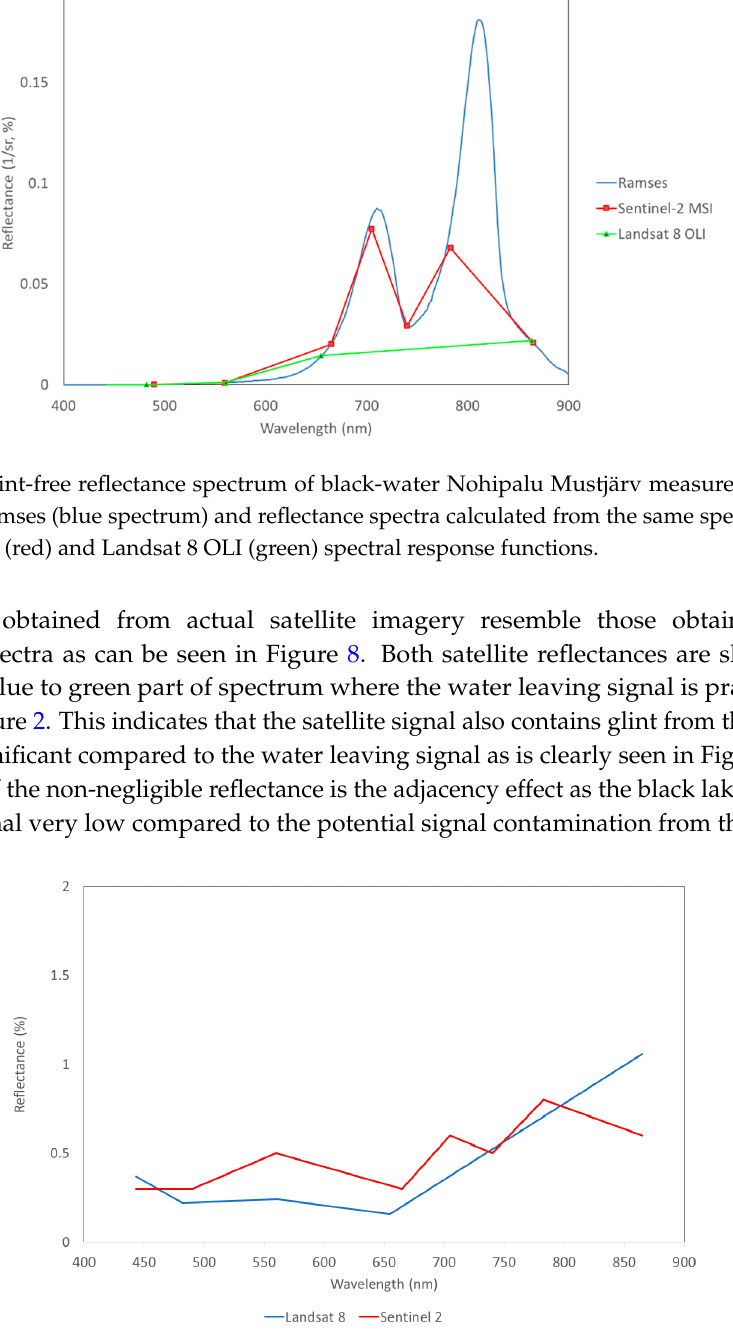
Figure 8. Reflectance spectra of black-water Nohipalu Mustjärv from two different satellites. The Blue line is ATCOR23 corrected Landsat 8 data and red line is Sen2Cor corrected Sentinel 2 data.